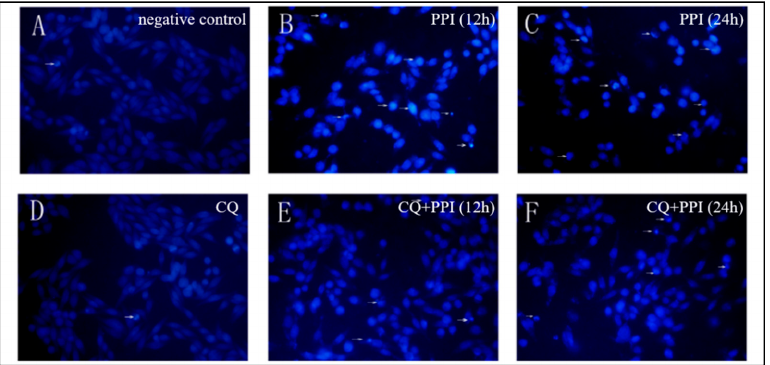
Figure 5. The changes in nuclear morphology were tested by DAPI staining after treatment with CQ (1000×). Note: ( A ): negative control group; ( B ): treated with 5 μ mol/L PPI for 12 h; ( C ): treated with 3.5 μ mol/L PPI for 24 h; ( D ): only treated with CQ; ( E ): treated with CQ and 5 μ mol/L PPI for 12 h; ( F ): treated with CQ and 3.5 μ mol/L PPI for 24 h. Arrows indicate the apoptotic cells.